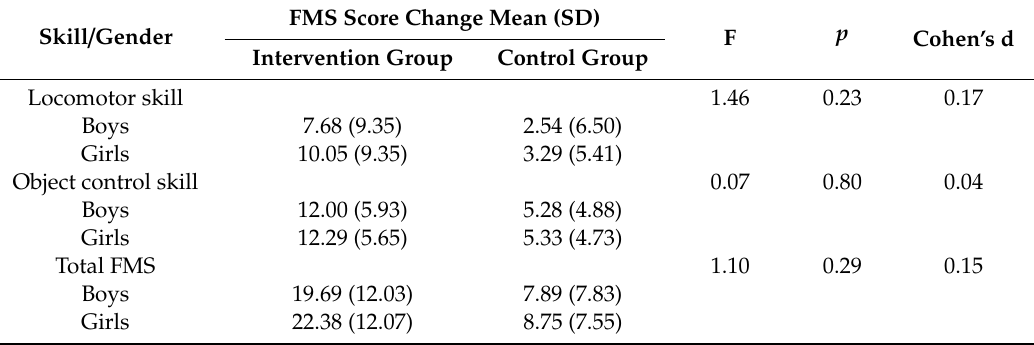
Table 4. Changes on FMS score between intervention and control group by gender ( n =